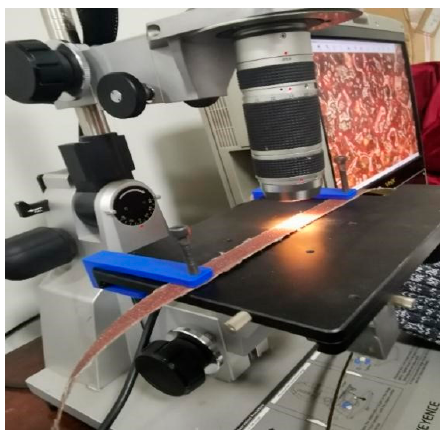
Figure 9. 3D printing fixture.